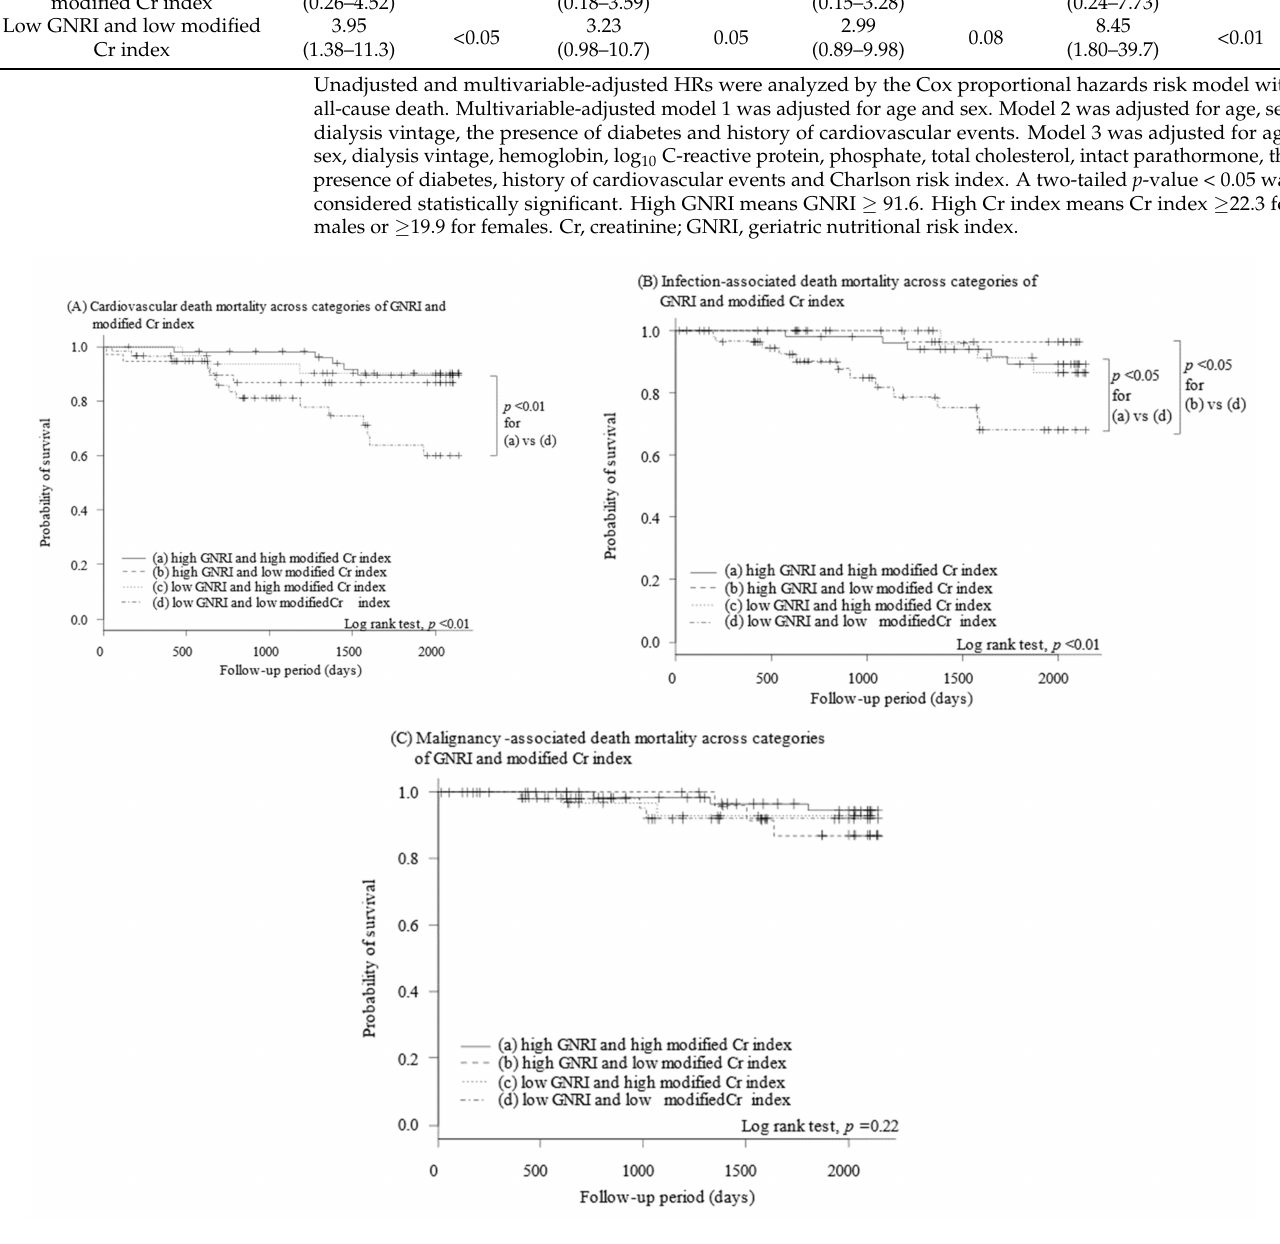
Figure 2. Five-year freedom free from cardiovascular death ( A ), infection death ( B ), and cancer death ( C ) stratified by a combination of GNRI and modified Cr index. Cr, creatinine; GNRI, geriatric nutritional risk